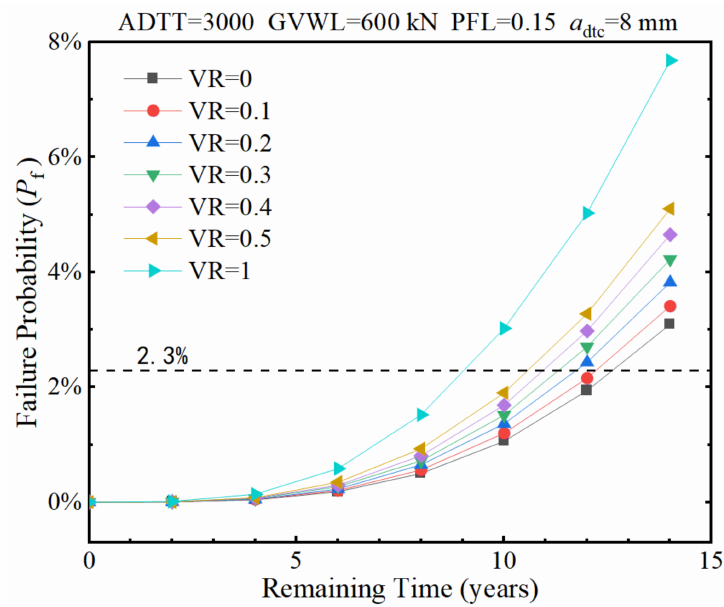
Figure 19. Failure probability of the fatigue detail under various VRs when the GVWL equals 600